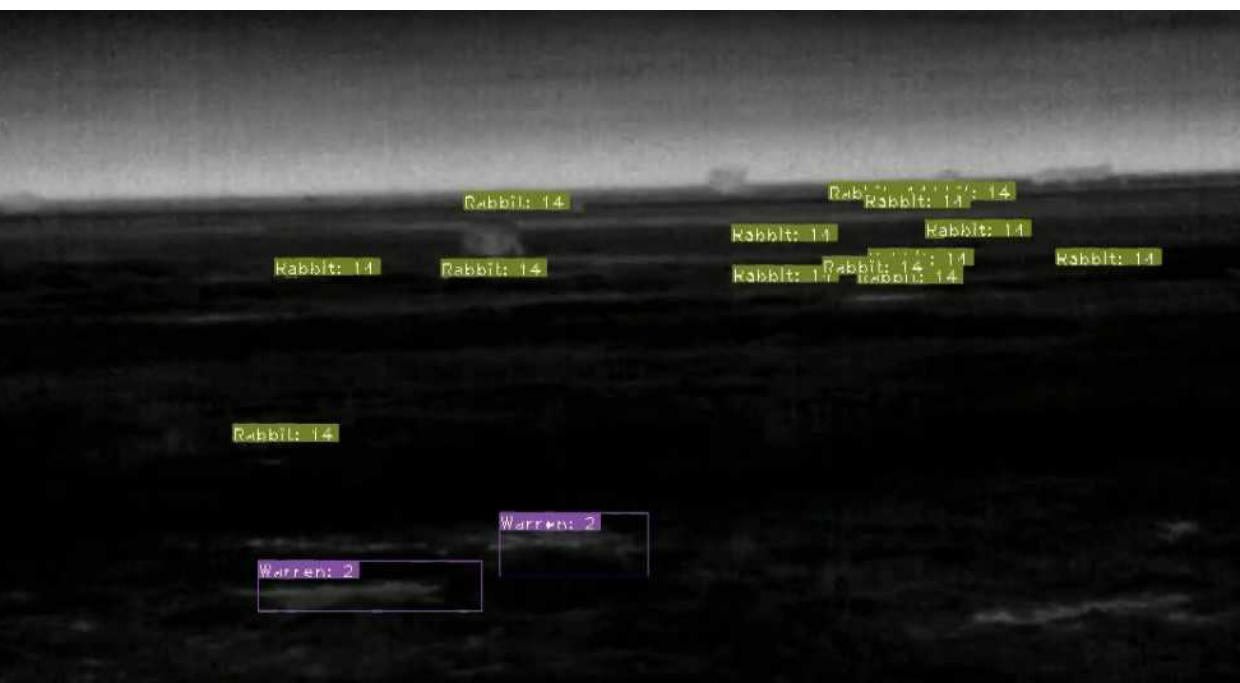
Figure 11. Identification of rabbits and their warren is shown with their respective labels found by our model. Yellow colour labels belong to rabbits, while purple colour labels are their